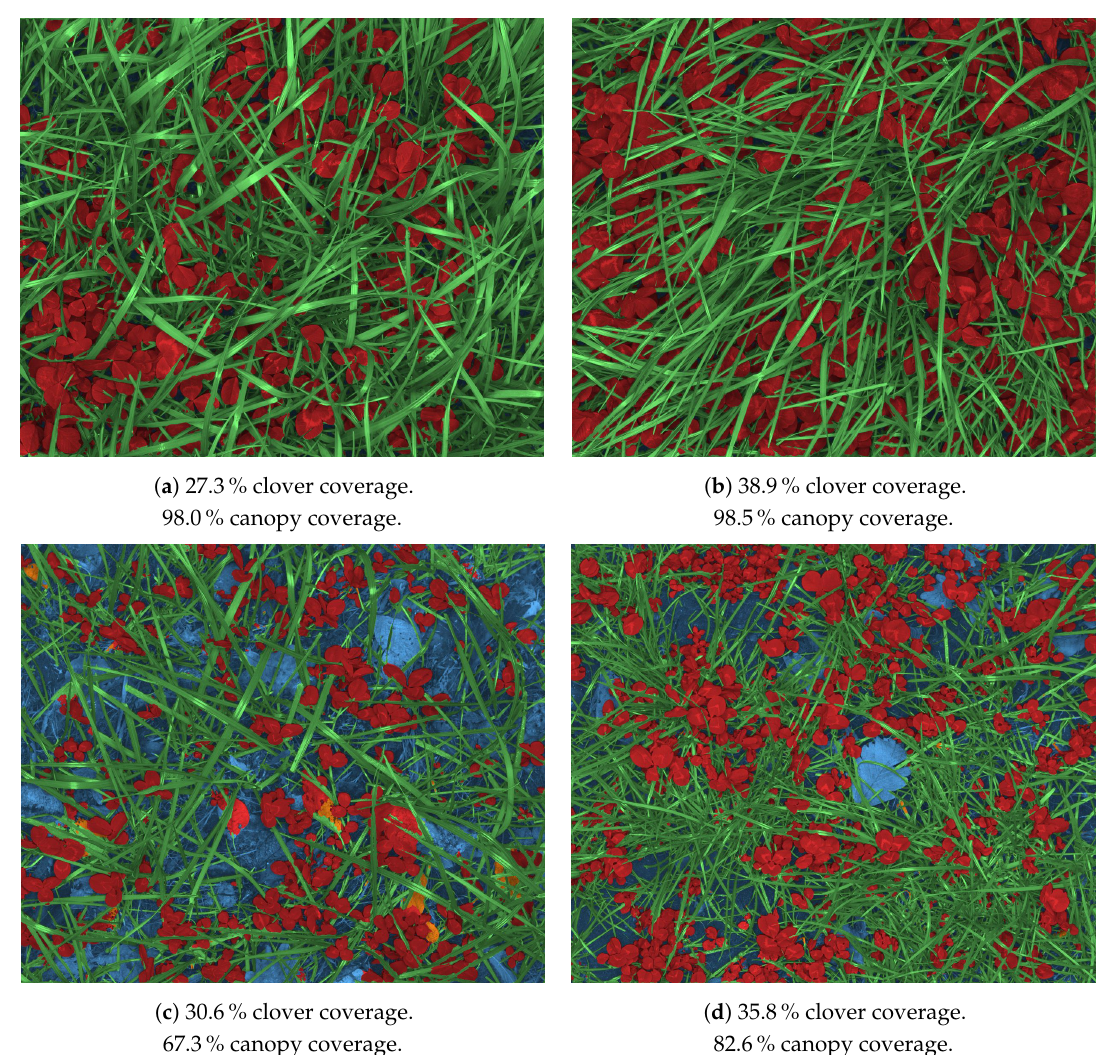
Figure 12. Pixelwise classification of the four large scale image acquisition samples from Figure 3. Blue is soil+background, red is clover, green is grass, and orange is weeds. The caption for each subfigure exemplifies the two automatically predicted metrics used for large scale